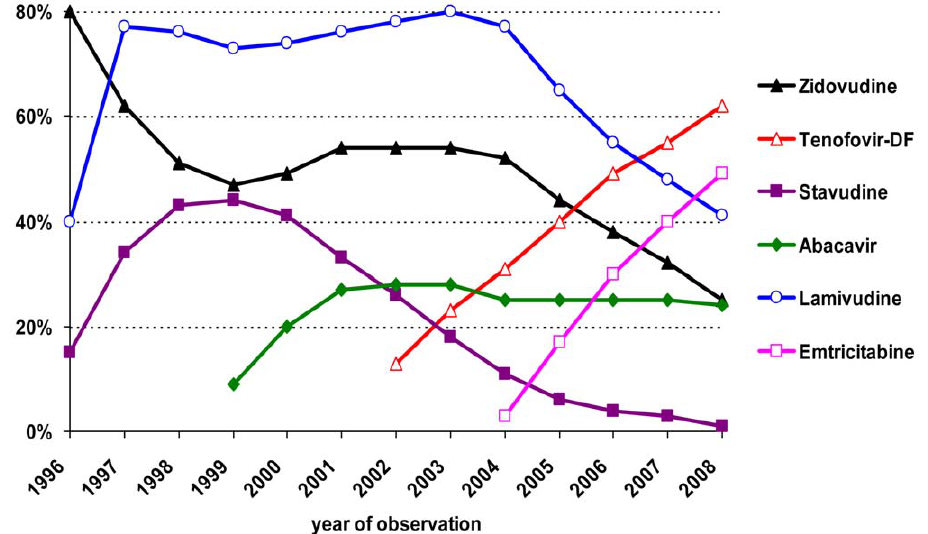
Figure 3. Market share of selected antiretrovirals of the nRTI-class (% of all treatment days per year).